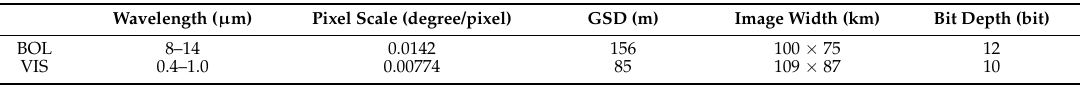
Table 1. Specifications of the un-cooled bolometer imager (BOL) and the visible monochromatic camera (VIS) onboard UNIFORM-1. At the given ground sampling distances (GSDs) and image widths, UNIFOMR-1 observes the ground from a 628 km altitude under the nadir condition. Wavelength ( µ m)